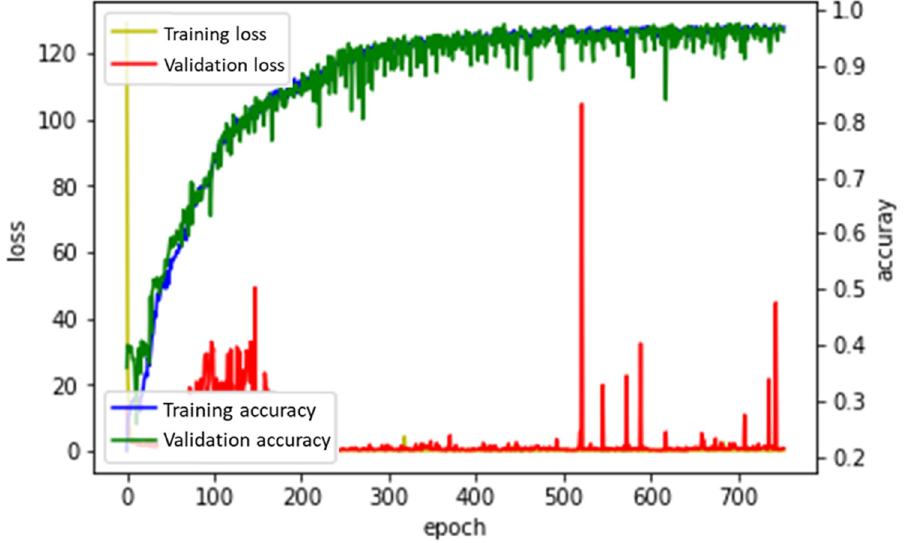
Figure 9. Performance graph by the RMSProp optimizer.